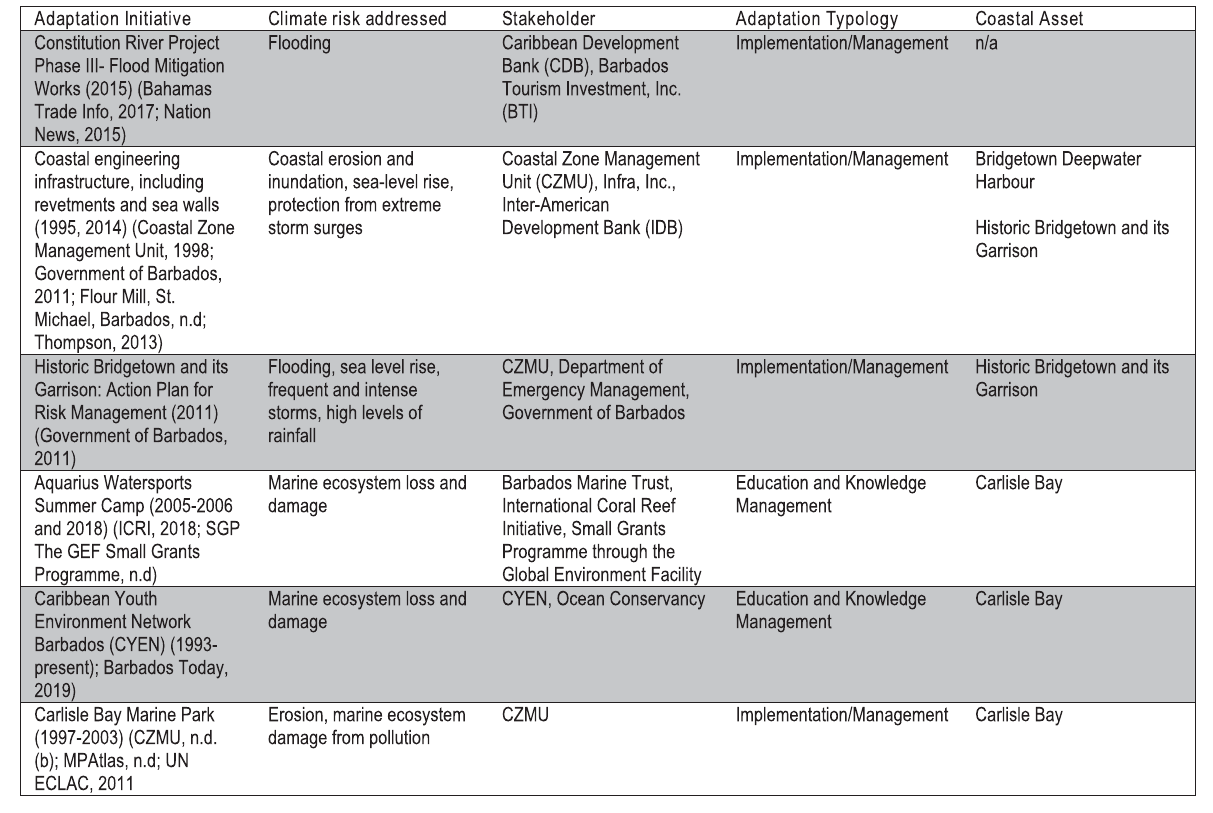
TABLE 1 | A Summary of Bridgetown-speci fi c